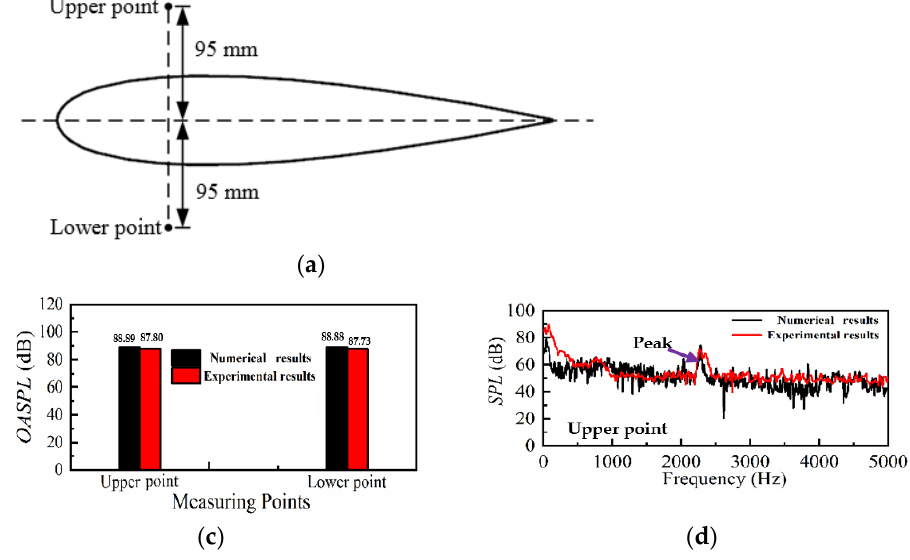
Figure 6. Comparison of the sound field results. ( a ) Experimental condition; ( b ) Comparison of OASPL ; ( c ) SPL spectrum.